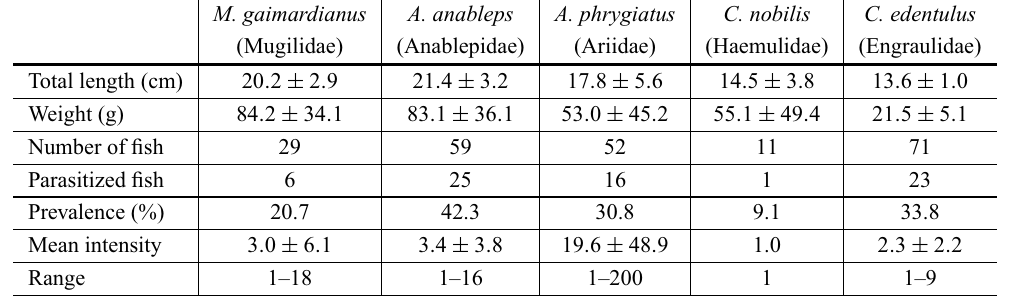
Biometric and parasitological data of the fishes captured from Northeast of Pará, Bragança, Brazil.